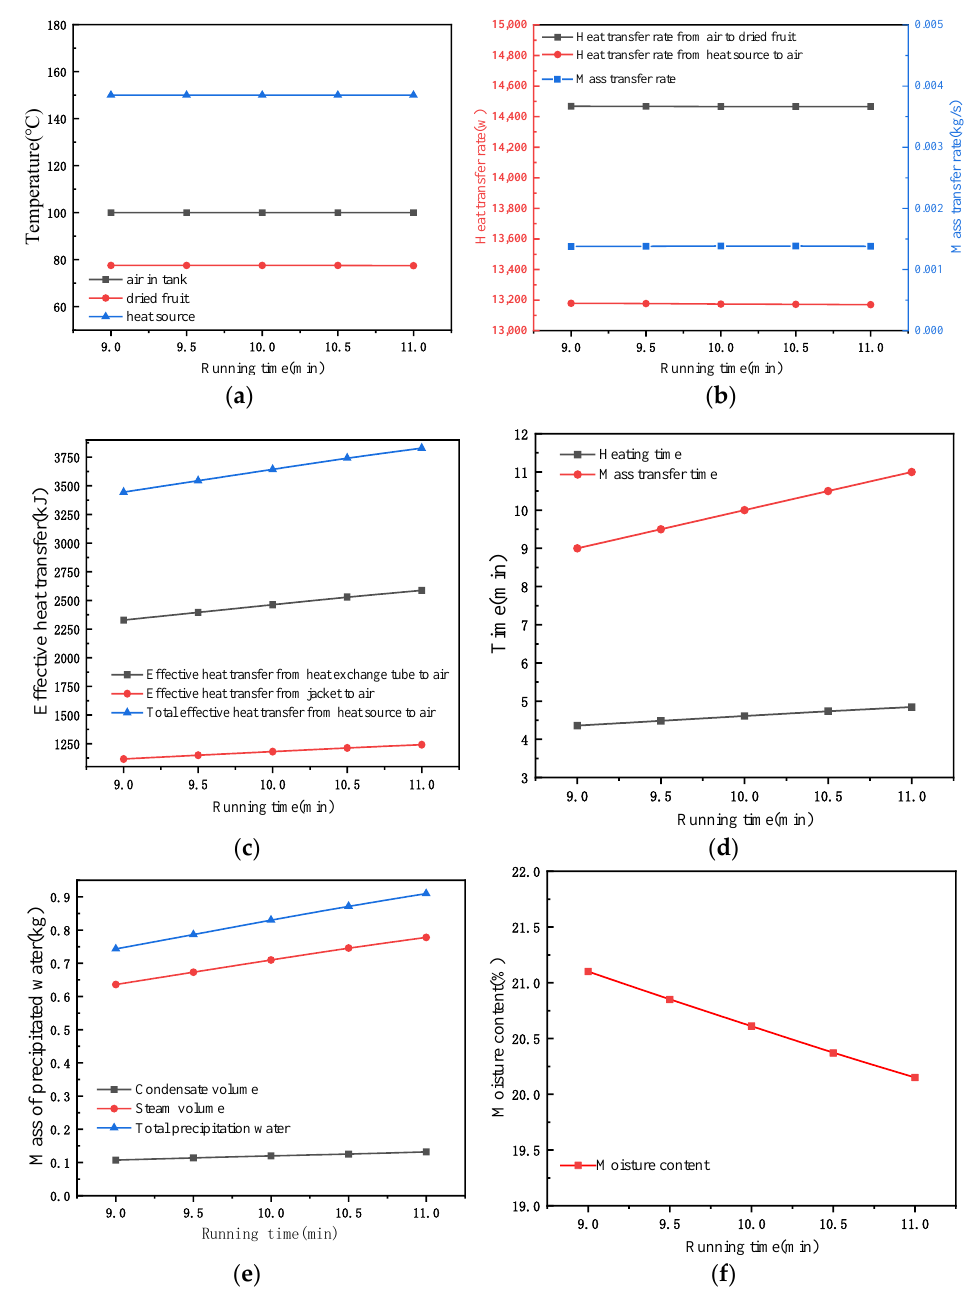
Figure 4. Effect of operation time on heat and mass transfer performance. ( a ) Effect of running time on temperature. ( b ) Effect of running time on heat and mass transfer power. ( c ) Effect of running time on heat transfer. ( d ) Effect of running time on heat transfer. ( e ) Effect of running time on precipitation and condensation water. ( f ) Effect of running time on dry fruit moisture content.